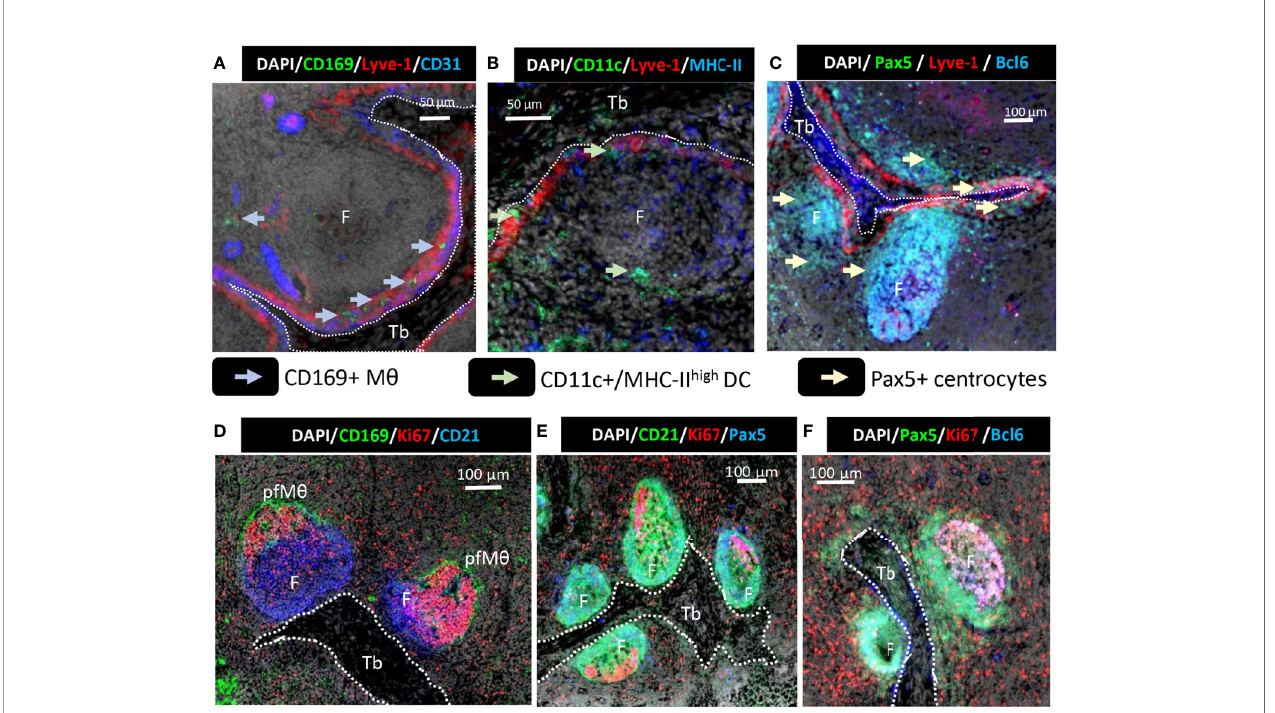
FIGURE 3 | Trabecular lymphatic sinus and B cell follicles relative positioning 10 µm thick sections of a tracheobronchial LN were stained using (A) anti-CD169, anti- Lyve-1, anti-CD31 antibodies and DAPI; (B) anti-CD11c, anti-Lyve-1, anti-MHC-II and DAPI; (C) anti-Pax5, anti-Lyve-1, anti-Bcl6 and DAPI, (D) anti-CD169, anti- Ki67, anti-CD21 and DAPI; (E) anti- CD21, anti-Ki67, anti-Pax5 and DAPI; (F) anti- Pax5, anti-Ki67, anti- Bcl6 and DAPI. F, follicle; Tb, Trabeculae; pfM q , perifollicular macrophages. Light blue arrow: CD169 pos macrophages, light green arrows: CD11c pos /MHC-II high dendritic cells, light yellow arrows: centrocytes. (A, B) , scale bar 50µm, (C – F) scale bar 100µm. Whole LN pictures are individual images from 10x objective acquisitions. Images are representative of 3 LN from different